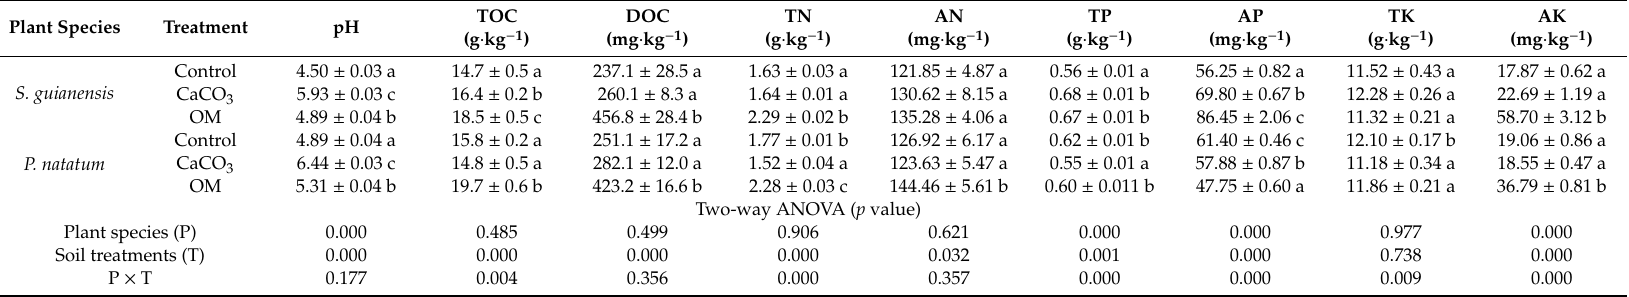
Table 1. Influences of liming (CaCO 3 ) and plant residue incorporation (OM) on soil chemical properties. TOC, total organic carbon; DOC, dissolved organic carbon; TN, total nitrogen; AN, available nitrogen; TP, total phosphorus; AP, available phosphorus; TK, total potassium; AK, available potassium. Data followed by the same letter are not significantly di ff erent for each plant species (Tukey’s post hoc, p = 0.05, n =